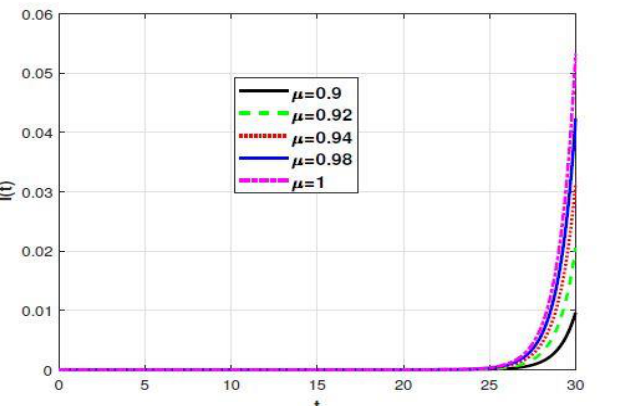
Fig. 2. Numerical experiments of infected asymptomatic infected undetected class for various value of fractional order 𝛍 .